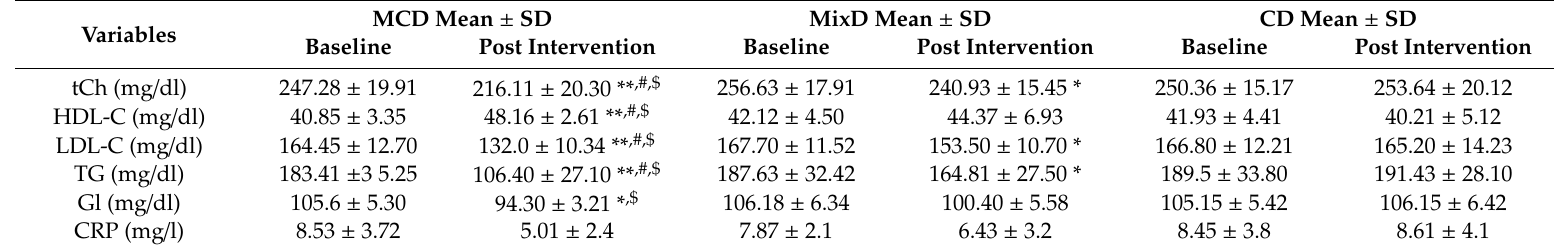
Table 2. Changes in biochemical variables after the dietary interventions of the moderate-carbohydrate diet (MCD), mix diet (MixD), and conventional diet (CD).